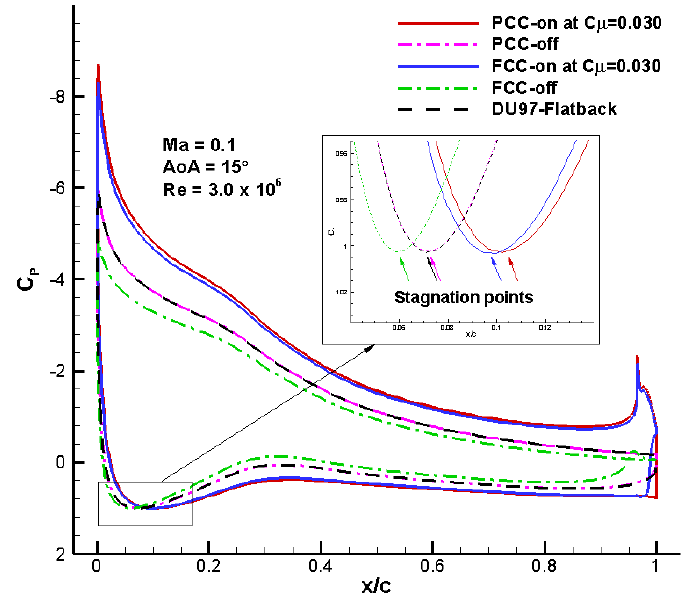
Figure 12. Comparison of pressure distributions at AoA = 15°.